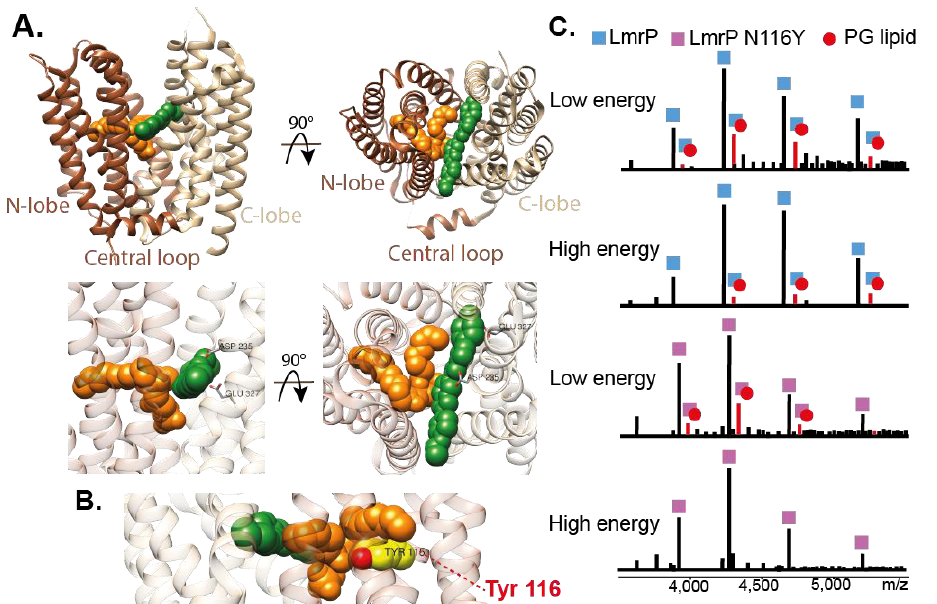
Figure 5. Structure of LmrP in complex with Hoechst 33342. ( A ) Cartoon representation of LmrP with the ligand Hoechst 33342 (green) and phosphatidic acid (orange) modeled from the densities observed (PDB ID 6T1Z). Hoechst 33342 forms polar interactions with D235 and E327 located in the C-lobe of LmrP. ( B ) Close up on the phospholipid. N116Y mutation perturbs lipid binding ( C ). nMS spectra showing compromised PG binding on the N116Y mutant. At a low activation energy (160 V), multiple lipids are bound to LmrP, including a peak corresponding to a single bound DOPG (in red). At high energy (200 V), this peak is still present. In the case of the N116Y mutant, although DOPG binds at low activation energy, it disappears at a high activation energy.